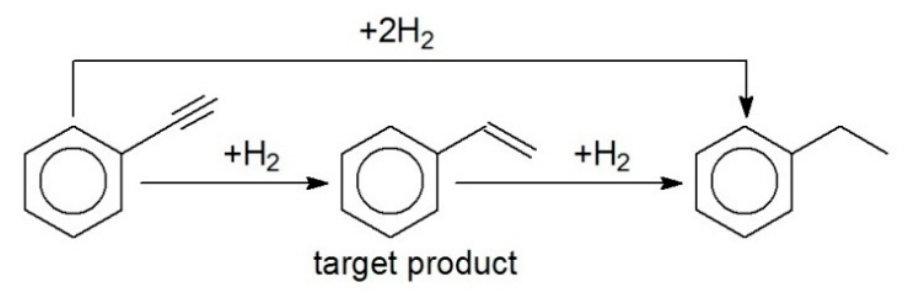
Figure 10. Scheme of selective hydrogenation of PHA to STY.